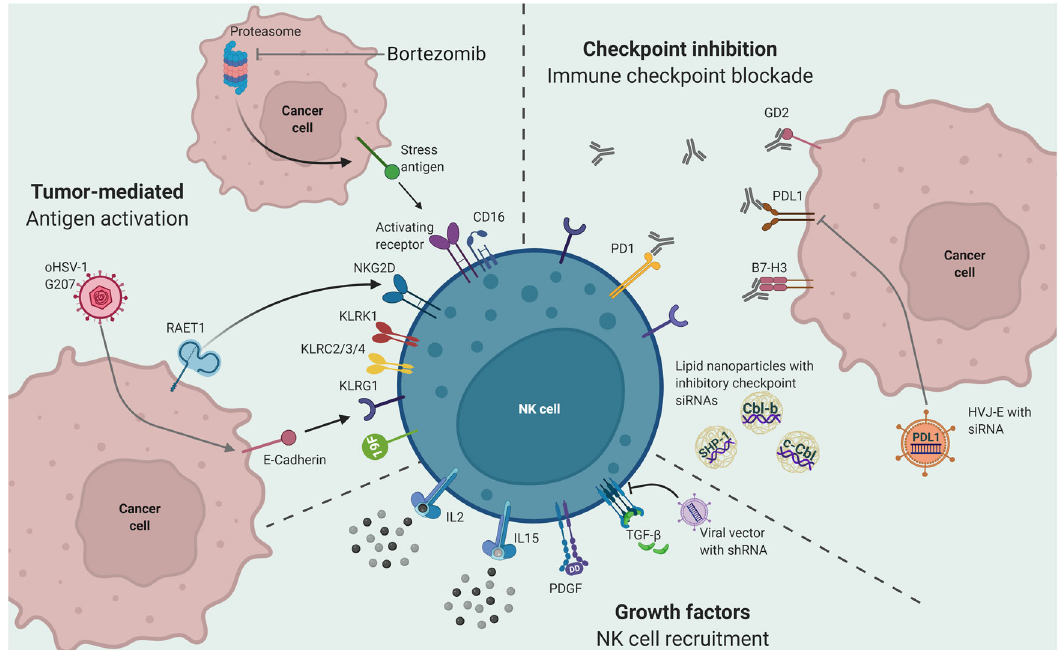
Fig. 3 Preclinical approaches of NK cell therapeutics in brain tumors. Preclinical approaches involving NK cells for the treatment of brain tumors focus on three modes of action. Tumor-mediated antigen activation includes the activation of NK cell activity by cancer cell antigen recognition. Recognition of stress antigens, expressed as a result of bortezomib treatment, can activate NK cell receptors. Expression of E- cadherin, primed by oHSV-1 G207, enhances NK cell recognition and activation of NK cells through the KLRG1 receptor. The recognition of the RAET1 antigen on cancer cells by the NKG2D receptor on NK cells can also lead to NK cell activation and cytotoxicity. Other receptors on NK cells, such as KLRK1, and KLRC2/3/4 have been reported to play a role in NK cell activation against cancer cells in the brain tumor microenvironment. Growth factors, such as IL2, IL15, and PDGFDD, promote NK cell recruitment and cytotoxicity. Inhibition of TGF-beta, using viral vectors carrying shRNA, has been shown to increase NK cell activation against brain tumor cancer cells in preclinical settings. Checkpoint inhibition and immune checkpoint blockade through antibodies against GD2, PD-L1, PD-1, and B7-H3, has been reported to enhance NK cell activity in brain tumors. Viral vectors carrying siRNA targeting PD-L1 on cancer cells or lipid nanoparticles carrying siRNAs against inhibitory checkpoints, such as Cbl-b, SHP-1, and c-Cbl, on NK cells, have also been reported to activate the NK cell immune response against brain tumor